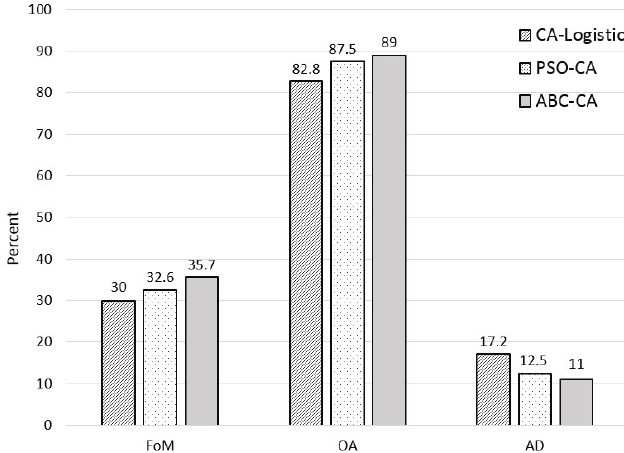
Figure 8. Statistical indices for the ABC-CA, PSO-CA, and CA-logistic models.